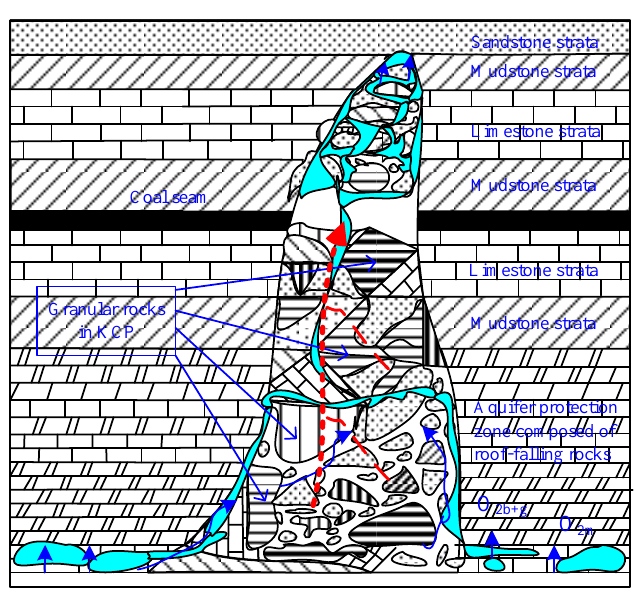
Figure 2. Granular rocks in the karst collapse pillar (KCP) and groundwater inrush pathway.